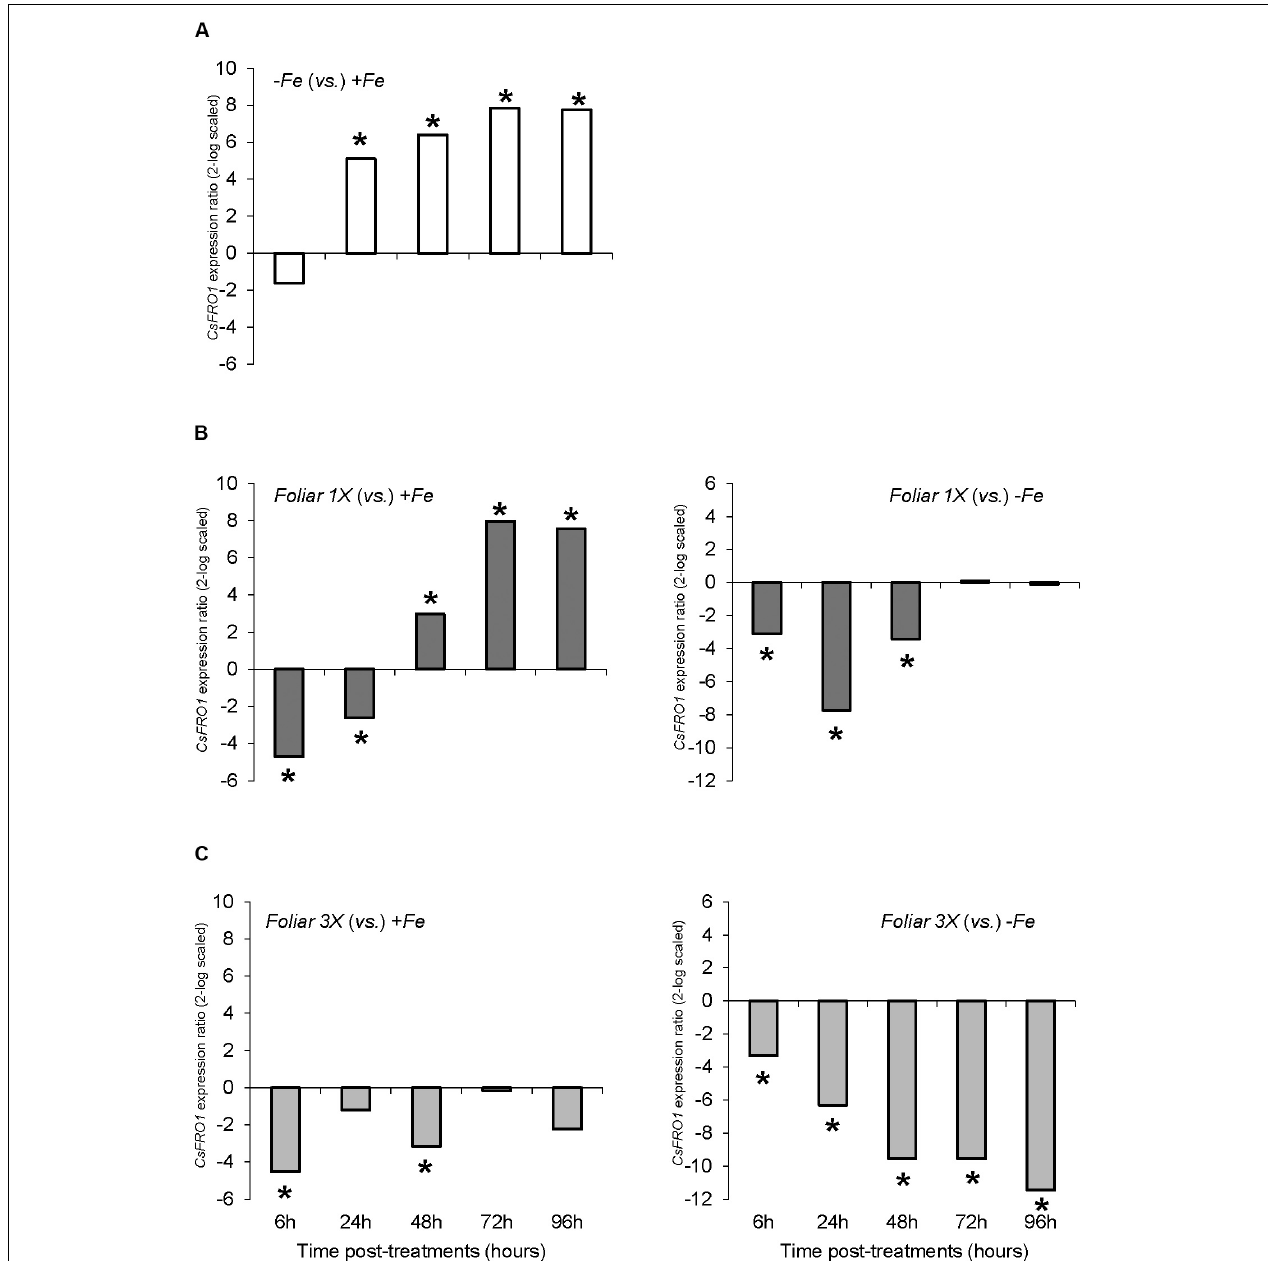
FIGURE 3 | CsFRO1 expression results in cucumber roots from Experiment I. Plants were grown in a nutrient solution with 5 µ M Fe, and then some of them were transferred to nutrient solutions with 40 µ M Fe (+ Fe ). The rest were transferred to nutrient solutions without Fe (– Fe ). A third of the – Fe plants were sprayed with a single dose of 9 mM FeSO 4 (2.54 mg Fe/plant, Foliar 1X ), and other third was sprayed during 3 consecutive days with 3 mM FeSO 4 (each plant received a total amount of 2.54 mg Fe/plant, Foliar 3X ). (A) Expression of CsFRO1 in root of – Fe plants versus + Fe plants. (B) Expression of CsFRO1 in root of Foliar 1X plants versus + Fe (left) and – Fe (right) plants. (C) Expression of CsFRO1 in root of Foliar 3X plants versus + Fe (left) and – Fe (right) plants. Data are means ± SE ( n = 5). Asterisks indicate significant differences between treatments at P < 0.05 based on one-way ANOVA and Fisher’s post hoc test. Statistical analysis of relative gene expression results was assessed using P-pairwise fixed reallocation randomization